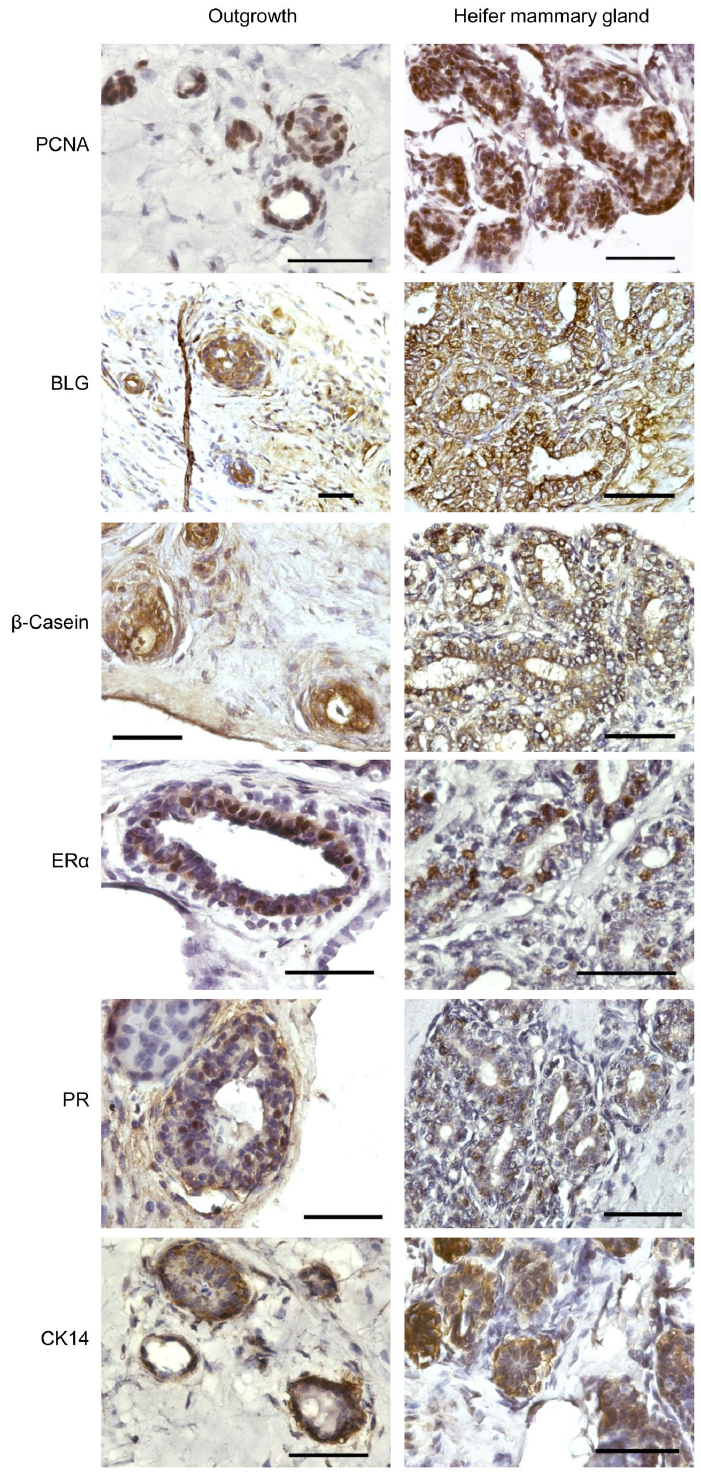
Figure 2. Bovine mammary outgrowths developed in the mouse, resemble the immunohistochemical characteristics of the donor tissue. Immunohistochemical analyses of selected markers on paraffin sections from bovine outgrowths (left panels) and mammary epithelium from heifer’s mammary gland (right panels). The outgrowths and the heifer’s tissue were subjected to similar histological procedures, including Carmine staining, prior to immunohistochemistry and hematoxylin counterstaining. Bar = 50 µm. doi: 10.1371/journal.pone.0068637.g002 PLOS ONE |